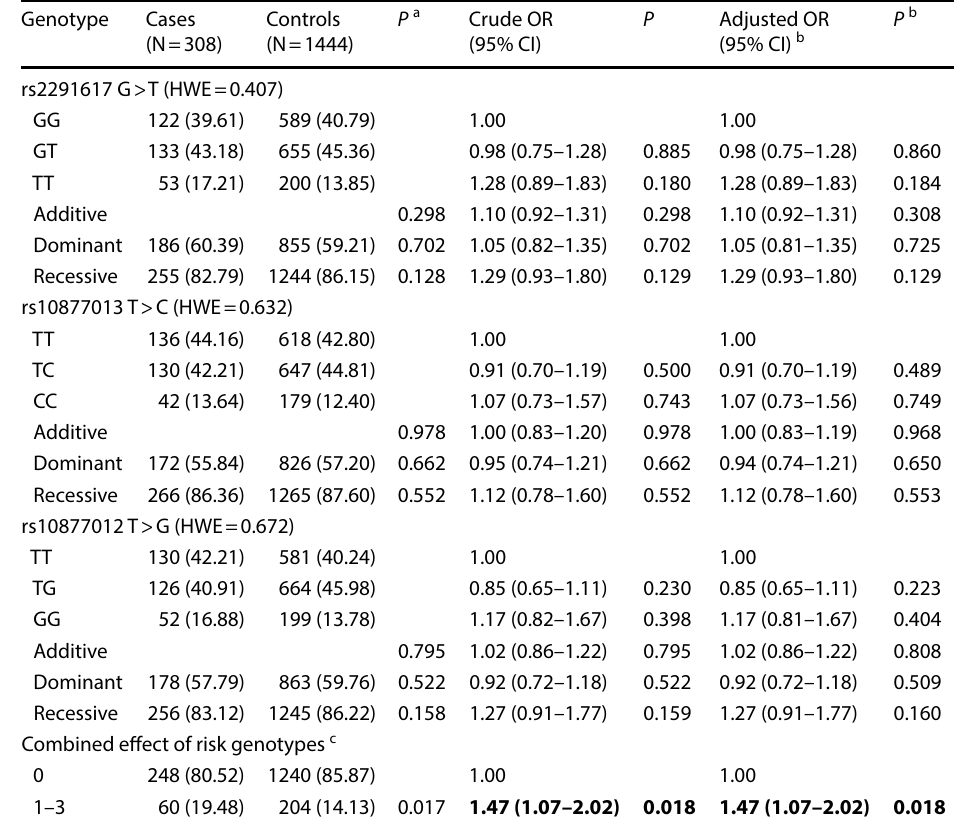
Table 1 The relationship between METTL1 gene polymorphisms and hepatoblastoma